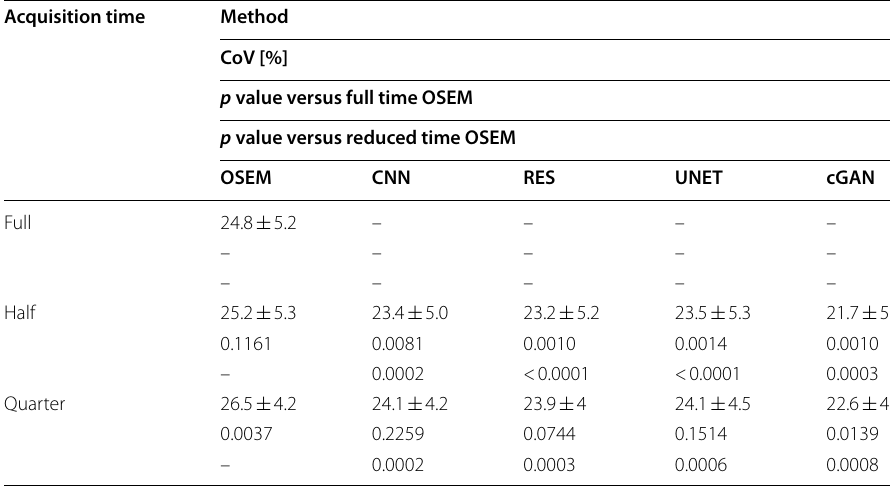
methods and acquisition times at